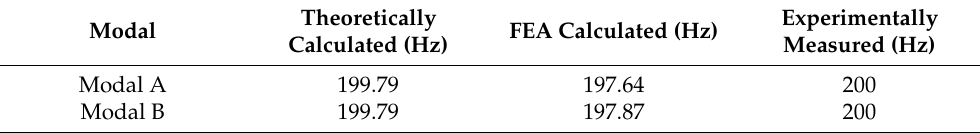
Table 2. First-order natural frequencies obtained from theory, FEA and experiment.